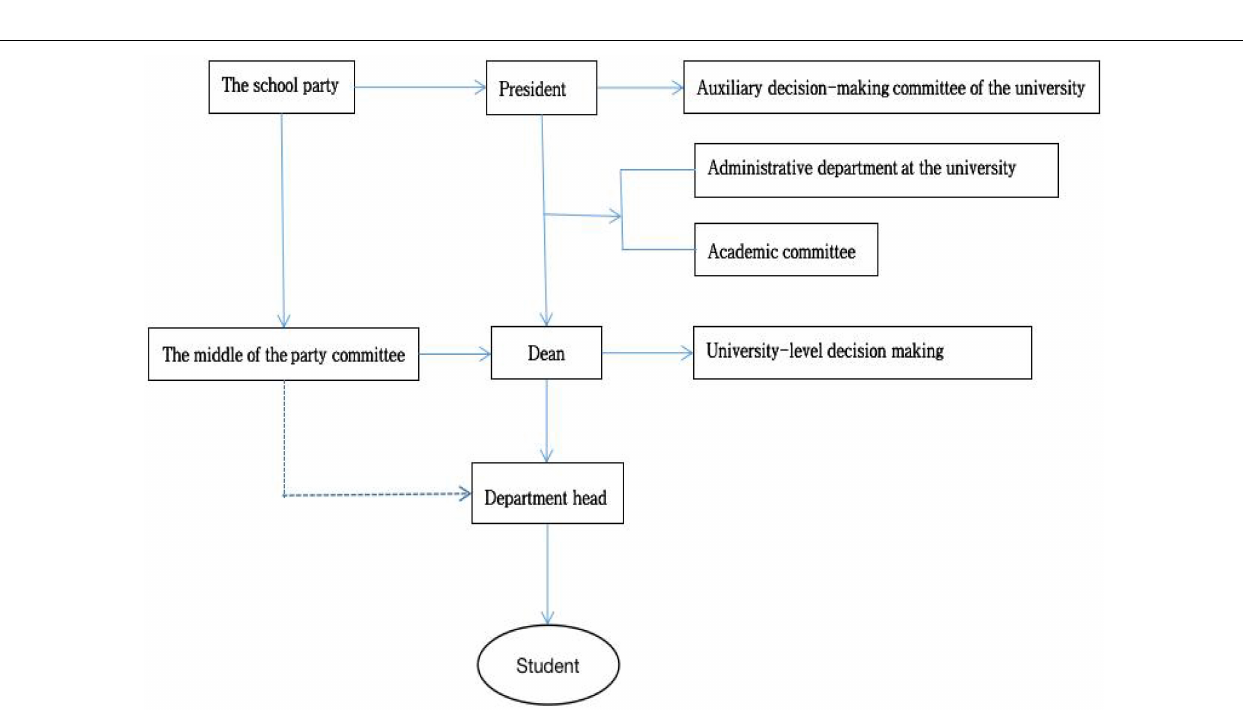
FIGURE 1 | Normal P-P diagram of standardized residuals of resignation psychological regression of interviewed college teachers.